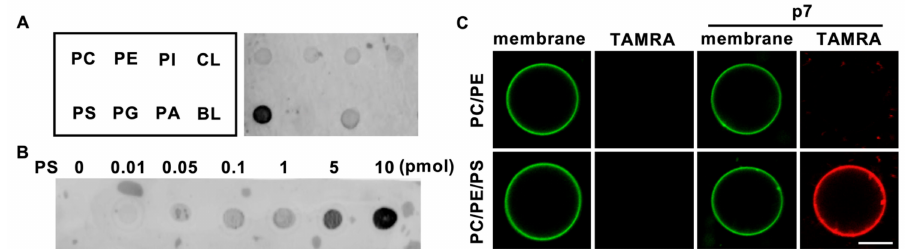
Figure 1. Lipid preference of hepatitis C virus (HCV) p7. ( A , B ) Lipid preference of p7 by a protein lipid overlay (PLO) assay. ( C ) p7 interaction with giant unilamellar vesicles (GUVs) composed of PC:PE, 3:1 (mol / mol), or PC:PE:PS, 3:1:1 (mol / mol). GUVs were electroformed with 0.2% TopFluor-cholesterol to visualize the membrane. TAMRA-p7 was applied to examine its targeting to GUVs. The scale bar indicates 10 µ m. PC, phosphatidylcholine; PE, phosphatidylethanolamine; PI, phosphatidylinositol; CL, cardiolipin; PS, phosphatidylserine; PG, phosphatidylglycerol; PA, phosphatidic acid; BL, blank.